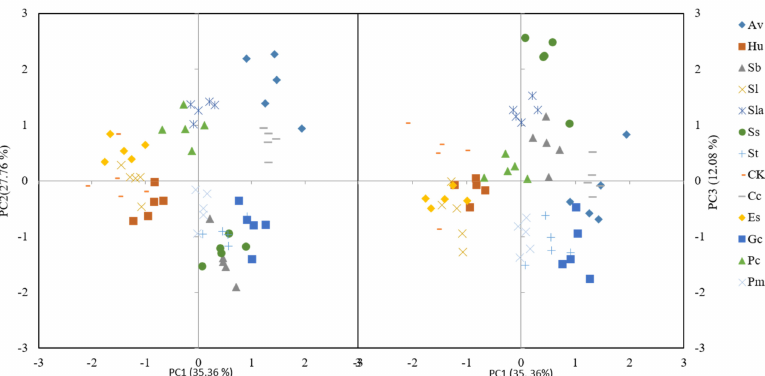
Figure 3. Principal component analysis (PCA) plots of three principal components of different inoculation treatments. PC1, principal 1, PC2, principal 2, PC3, Principal 3. Av, Hu, Sb, Sl,